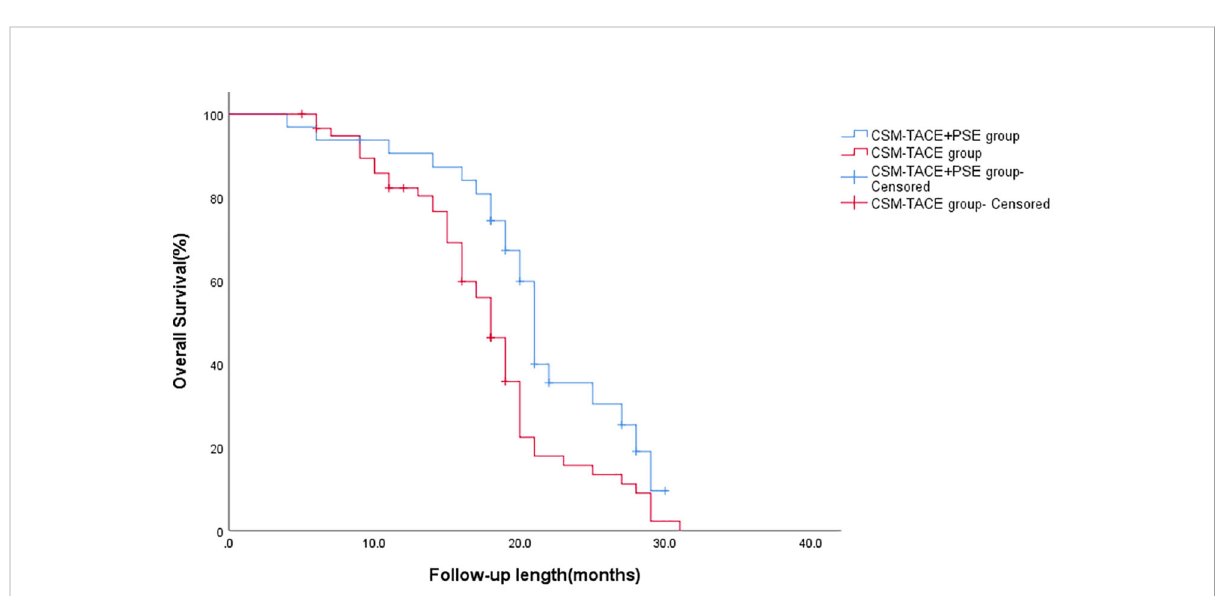
FIGURE 5 The overall survival